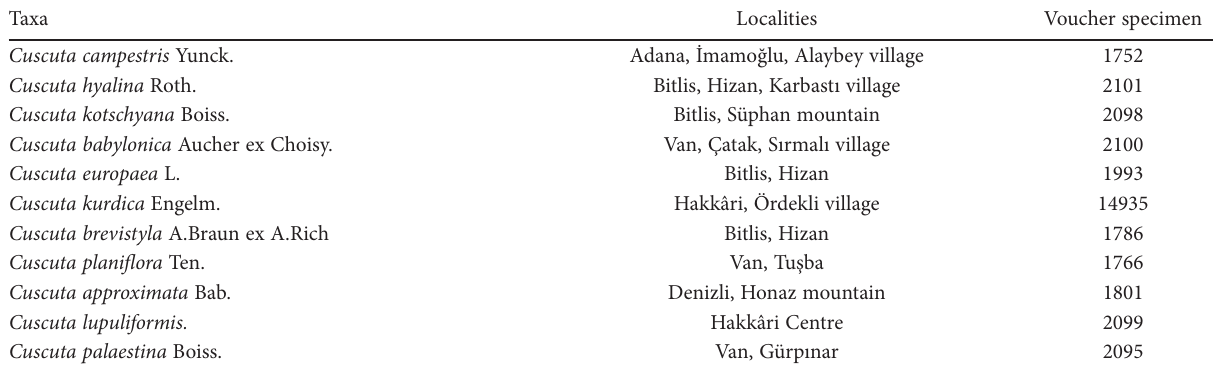
Table 1. The localities of studied